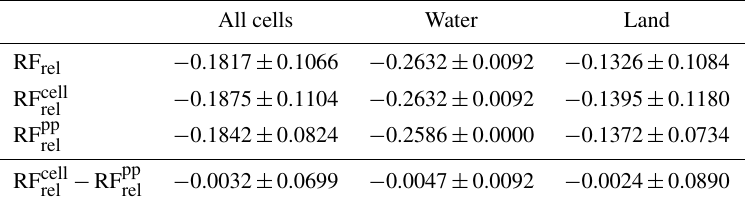
Table 3. Mean relative radiative forcing RF calculated concerning the actual surface, RF rel , and the horizontal cell surface RF cell 3-D Monte Carlo model. RF pp is RF computed, using the plane-parallel geometry to each column independently. Computations were done rel for λ = 469nm, solar zenith angle = 57 ◦ , solar azimuth = 173 ◦ , and aerosol properties of the 191st day of 2015.